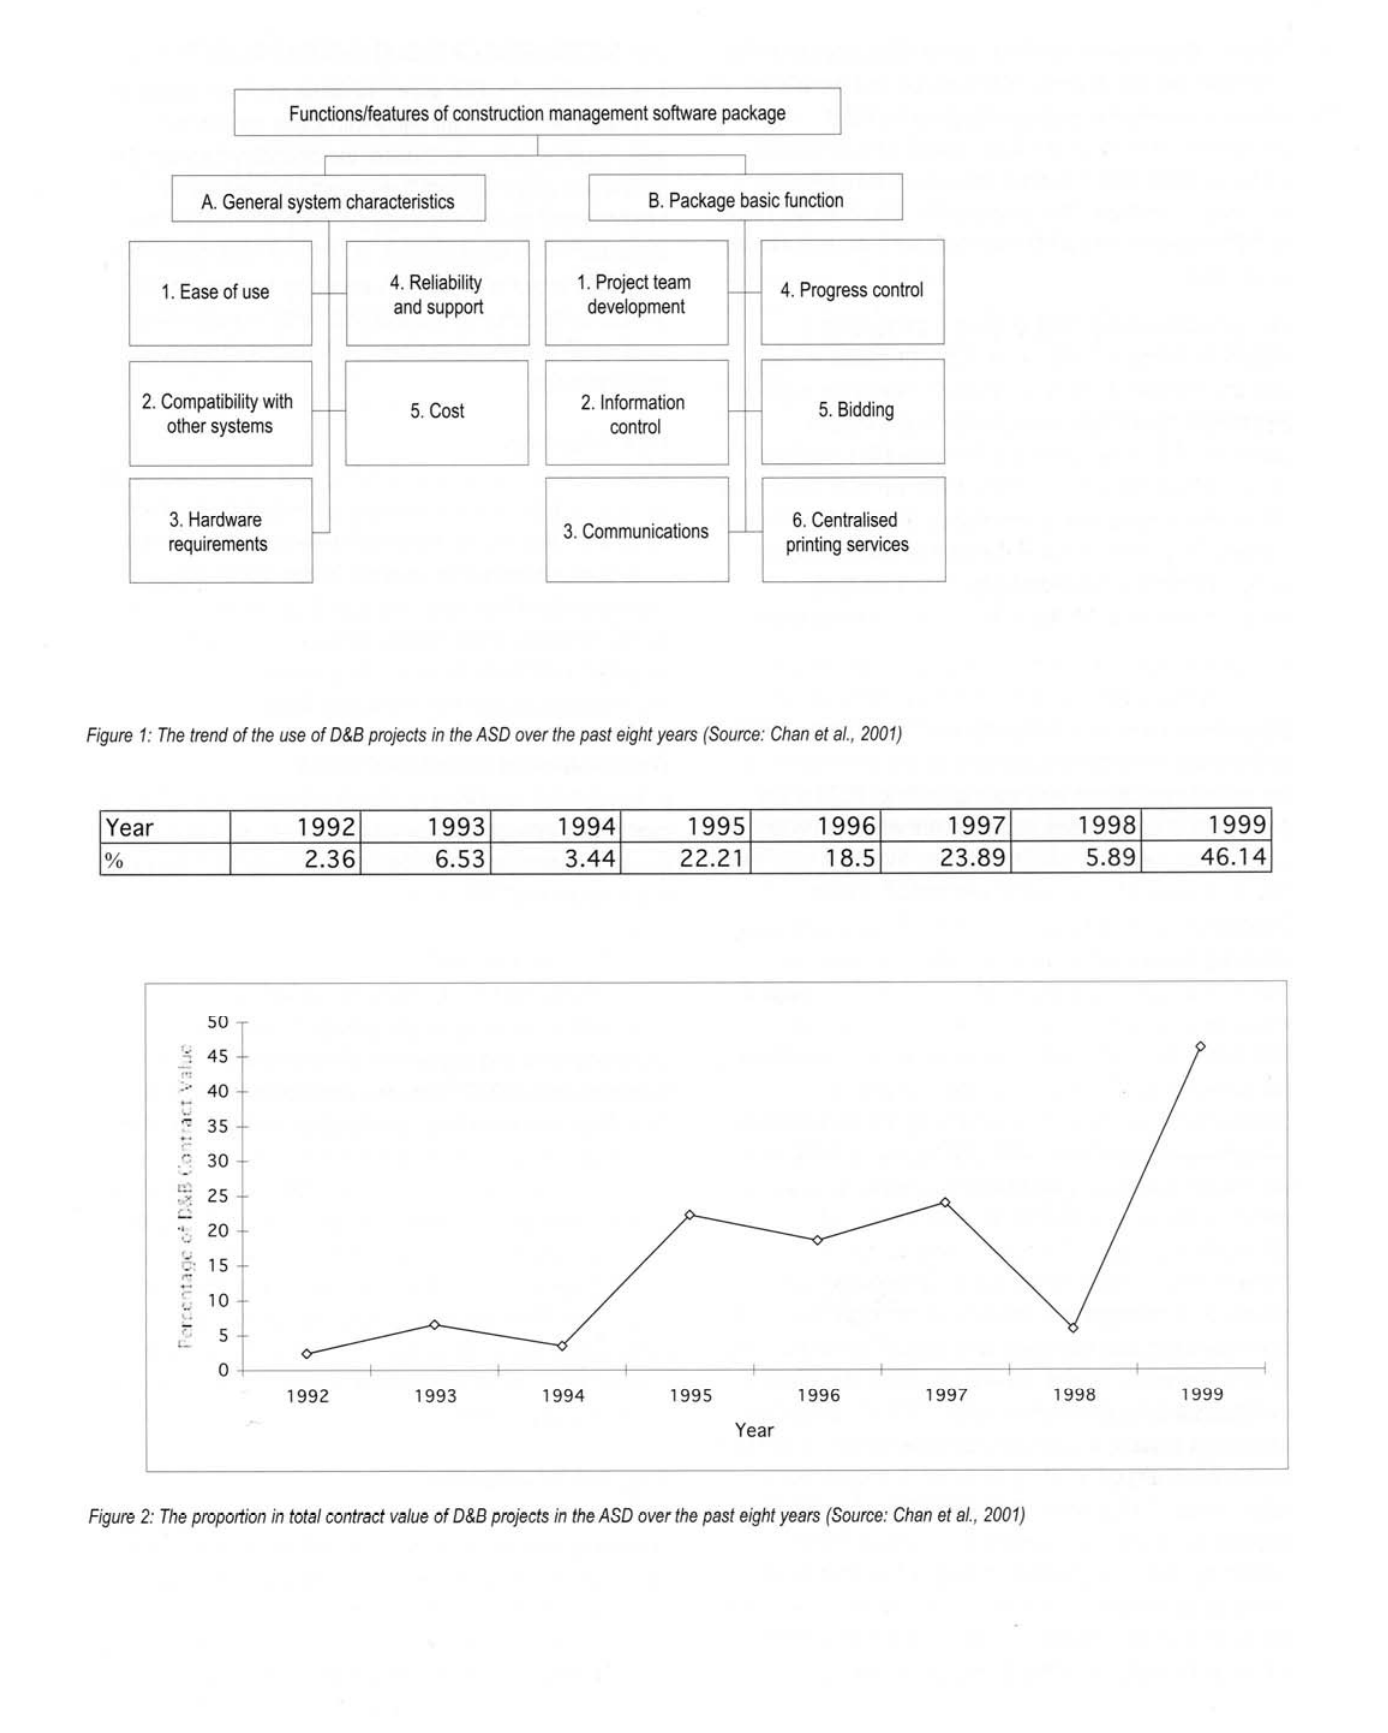
Figure 2: The proportion in total contract value of D&B projects in the ASD over the past eight years (Source: Chan et al.,